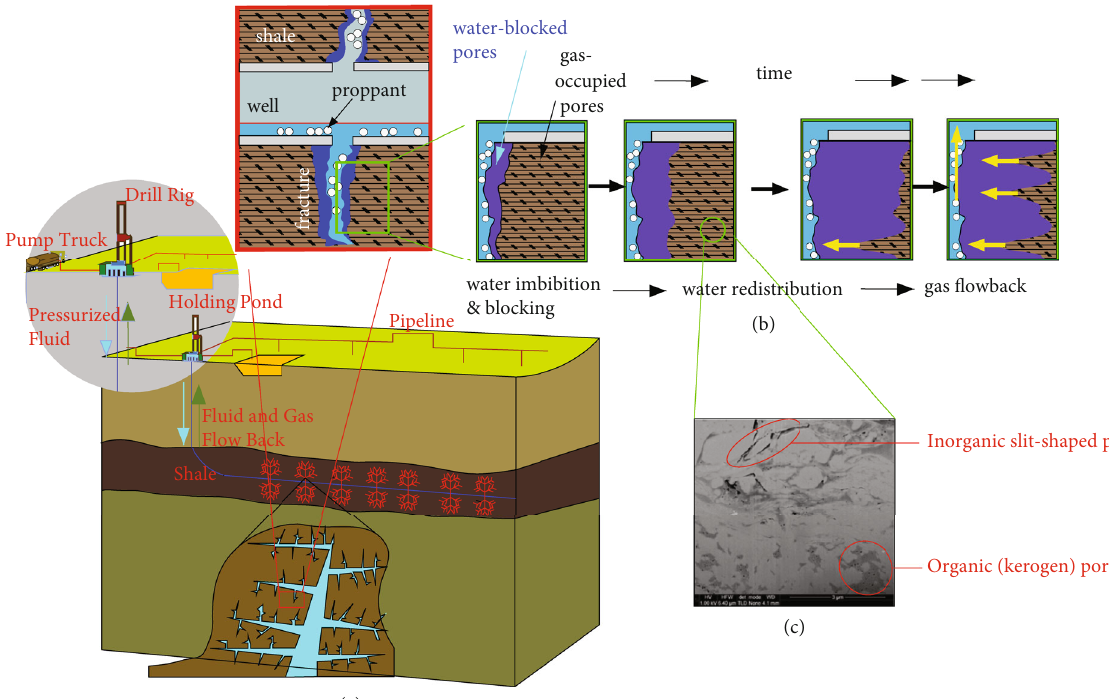
Figure 1: (a) Schematic illustration of shale gas HF. (b) Water imbibition process in a shale reservoir. (c) SEM image of the shale